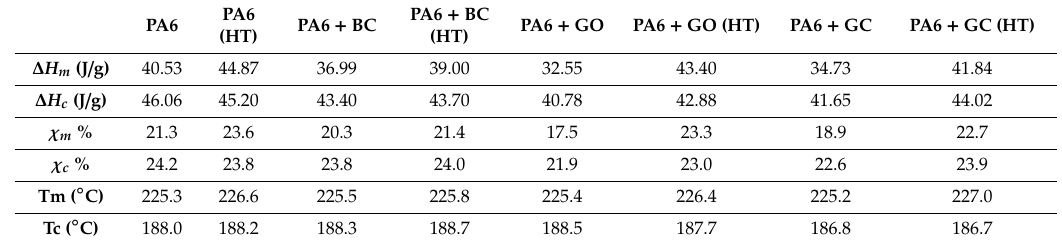
Figure 5. DSC curves for heating ( a ) and cooling ( b ). Table 2. DSC results of obtained